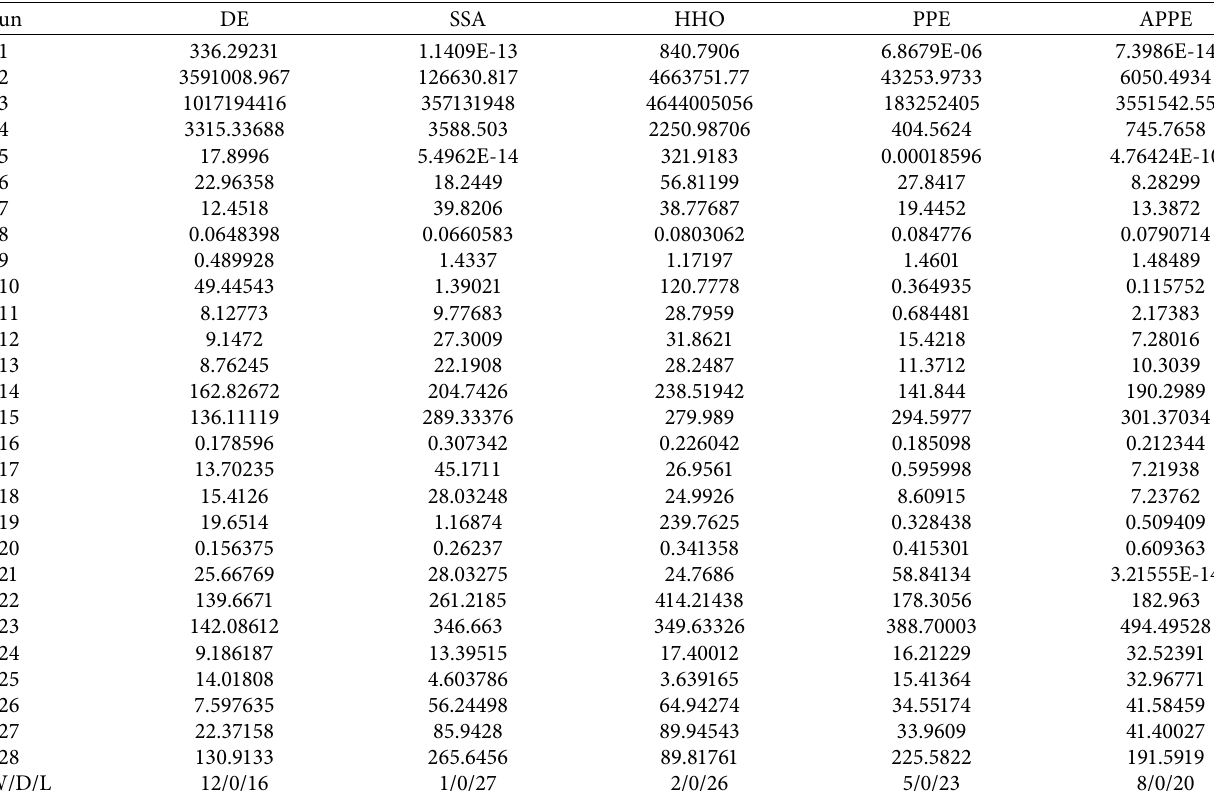
Table 4: Comparison of the standard deviation result of 51 runs on 10D in 28 benchmark